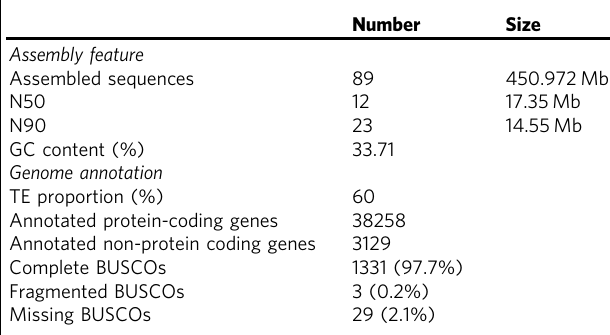
Table 1 Statistics of the white lupin genome and gene models